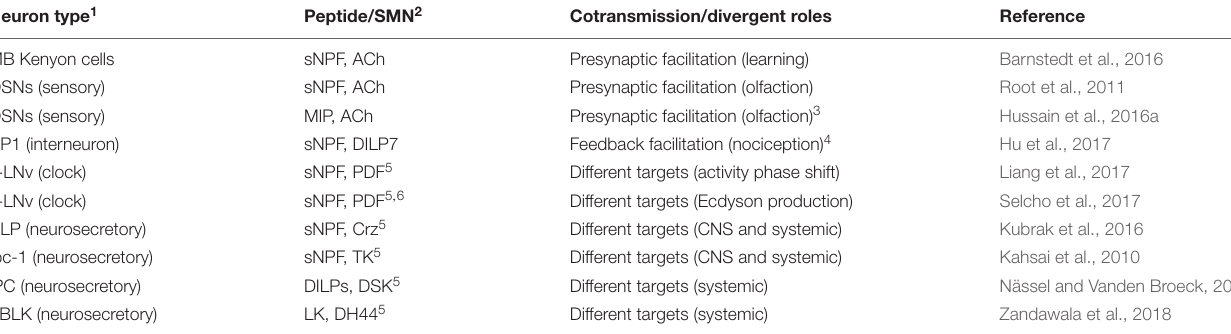
TABLE 5 | Summary of established functional roles of colocalized neuropeptides/SMNs in Drosophila